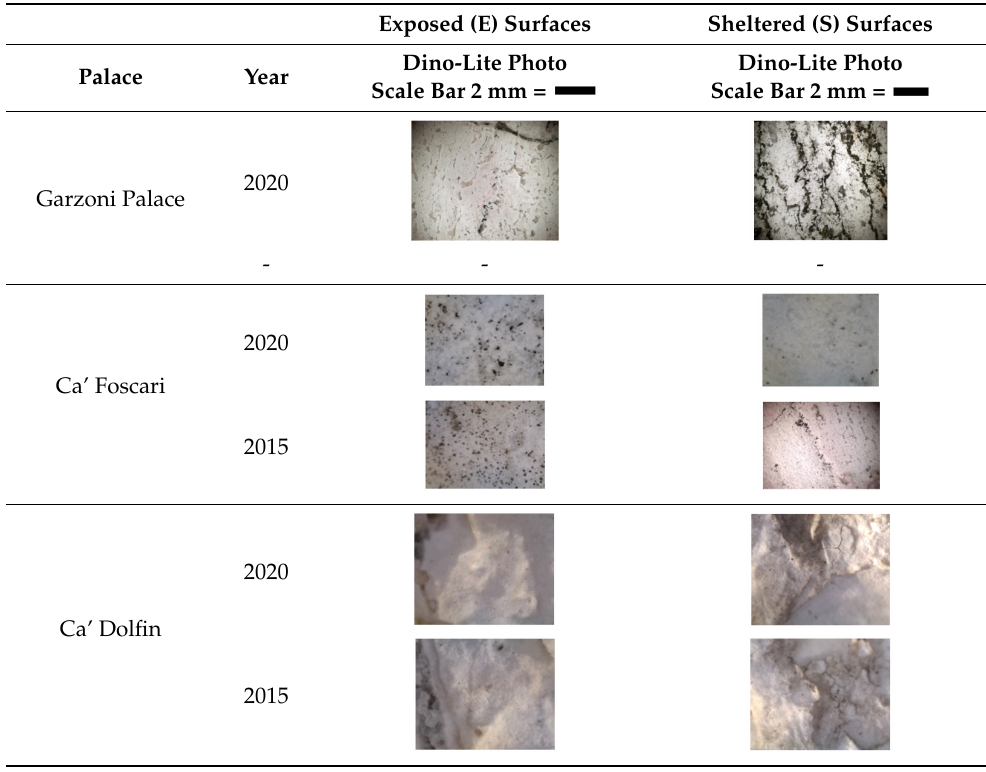
Table 1. Microscopical observation (54 × ) of the surfaces of Garzoni Palace, Ca’ Foscari, and Ca’ Dolfin calculated for